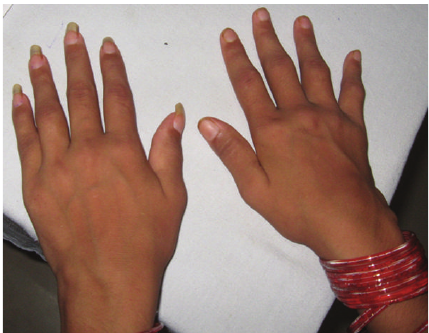
Figure 1: Symmetrical synovitis of wrists, ankles, and small joints of the